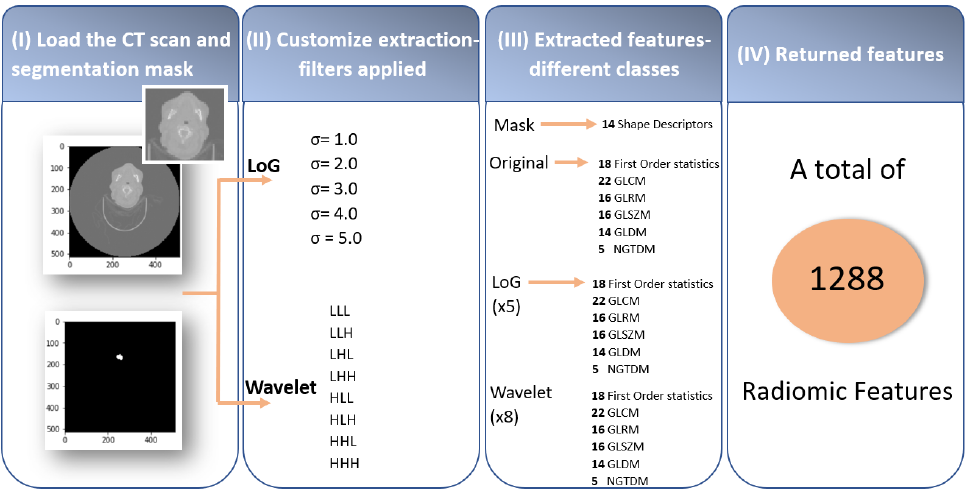
Figure 3. Summary scheme representing the 4 fundamental steps for the extraction of radiomic features. Initially, on the acquired medical images, a segmentation of the ROI is performed, followed by the customisation of the feature extraction from the segmented region by applying filters. Later, the extracted features (e.g., features based on tumour intensity, shape, and texture) are analysed in terms of their ability to predict valuable information for treatment